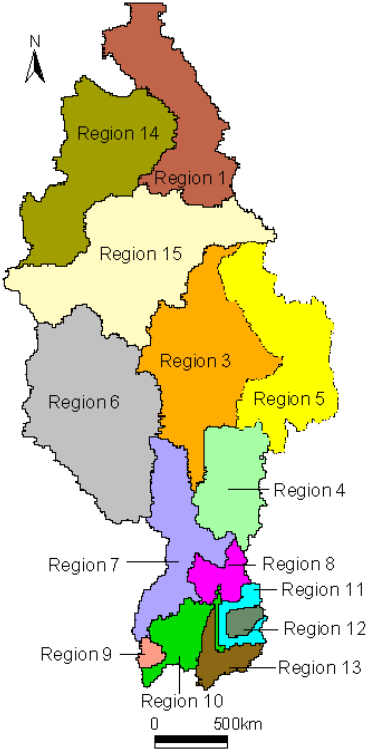
Fig. 2. Sub-catchments of the River Nile basin delineated using Ar- cView GIS from which several catchment characteristics were ex- tracted and used for cluster analysis.